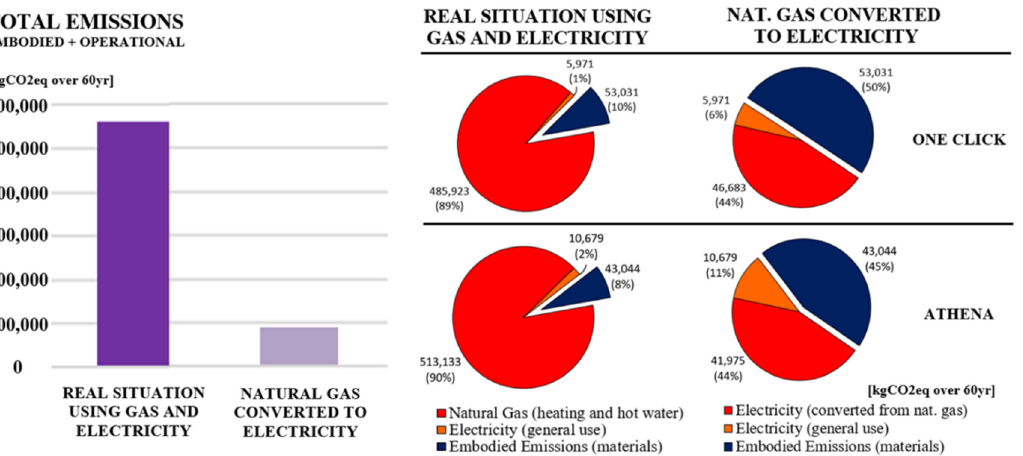
Figure 8. Comparison between real situation (scenario 1) and gas-free (scenario 3) for the single- detached house.